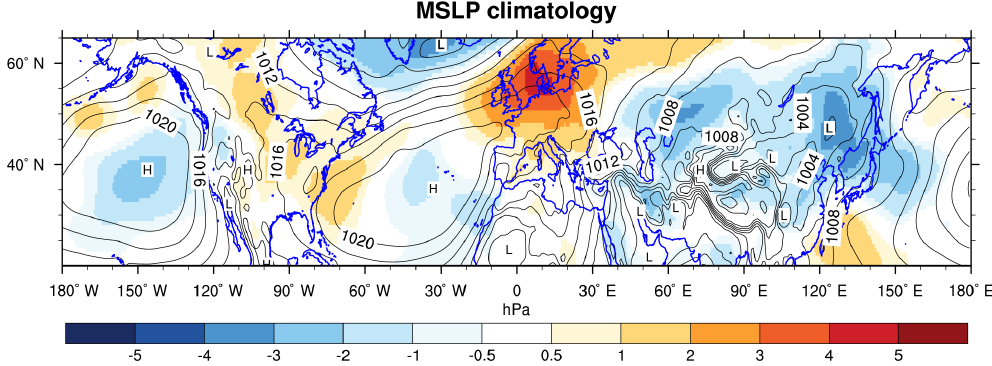
Figure 4. Mean sea level pressure climatology for July and August 2013 (black solid lines) from ERA-Interim. The shaded areas show the anomaly during July and August 2013 compared to the period